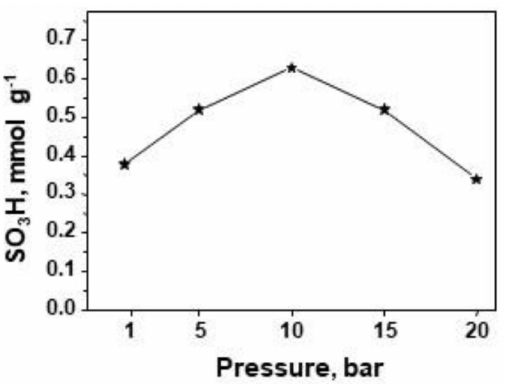
Figure 3. Influence of pressure applied during modification on concentration of acid sites.